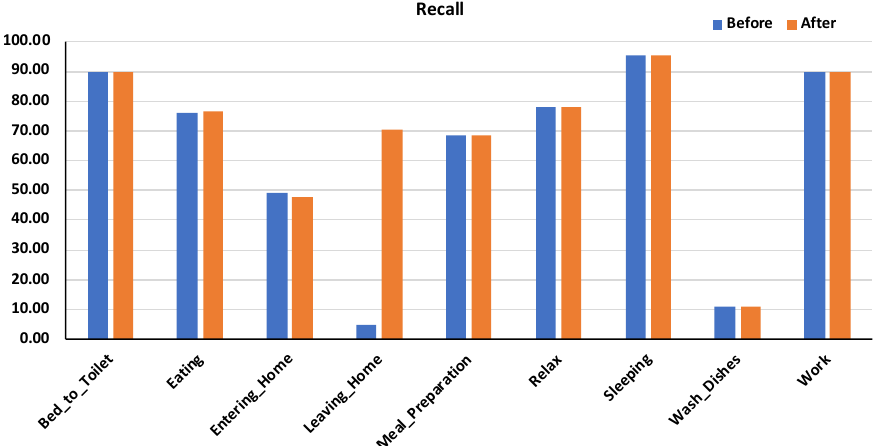
Figure 10. Comparison of recall values of paradigm #3 before and after applying semantic preprocessing. Note the big improvement that is achieved with the preprocessed activity Leaving_Home .